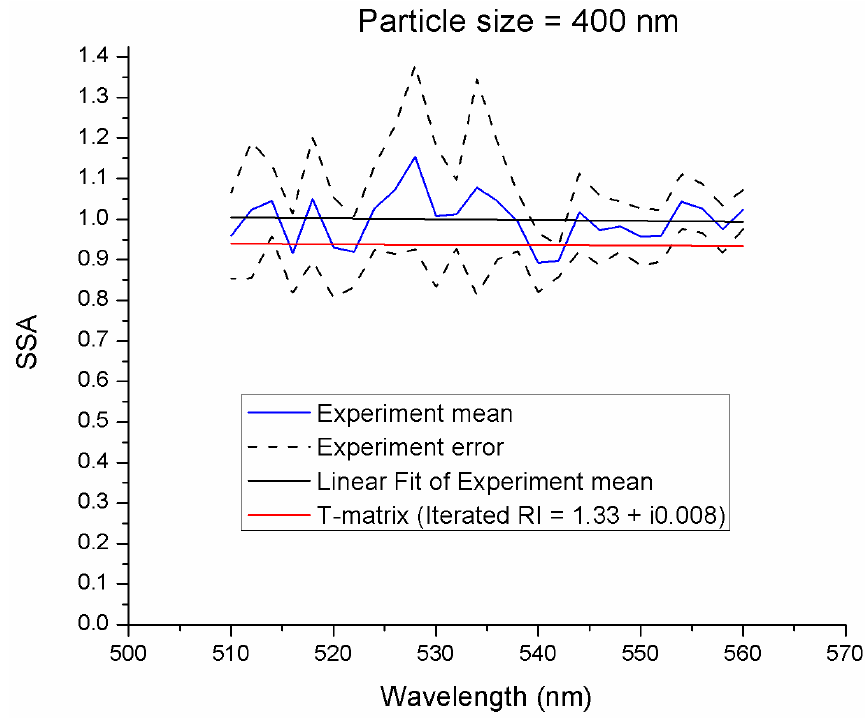
Figure 7. Comparison of T-matrix SSA using (RI = 1.33 + i0.008) with experimental SSA for 400-nm fresh BB particles produced using a tube furnace.